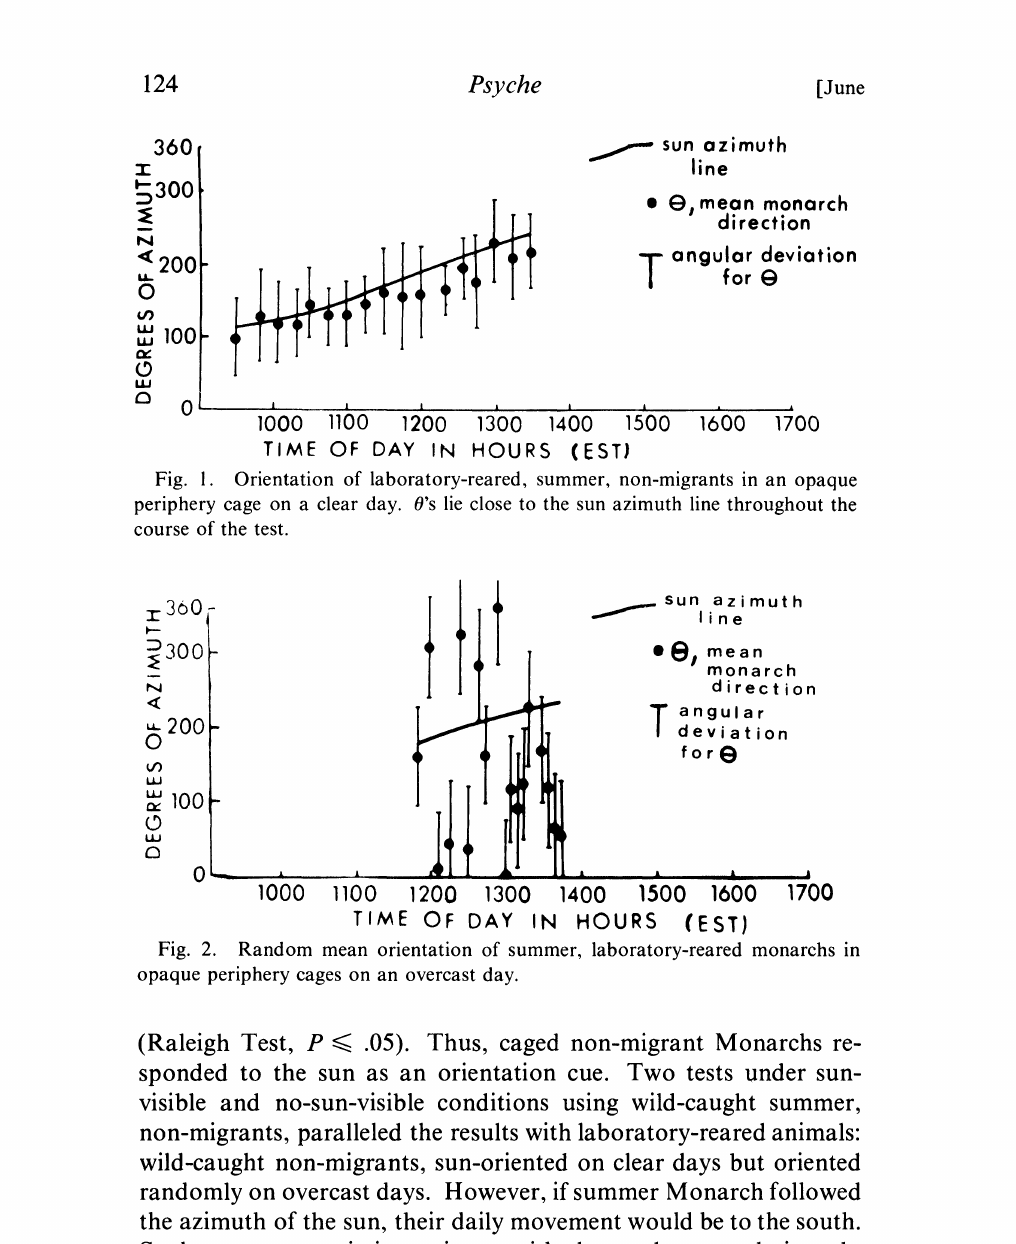
Fig. 2. Random mean orientation of summer, laboratory-reared monarchs in opaque periphery cages on an overcast